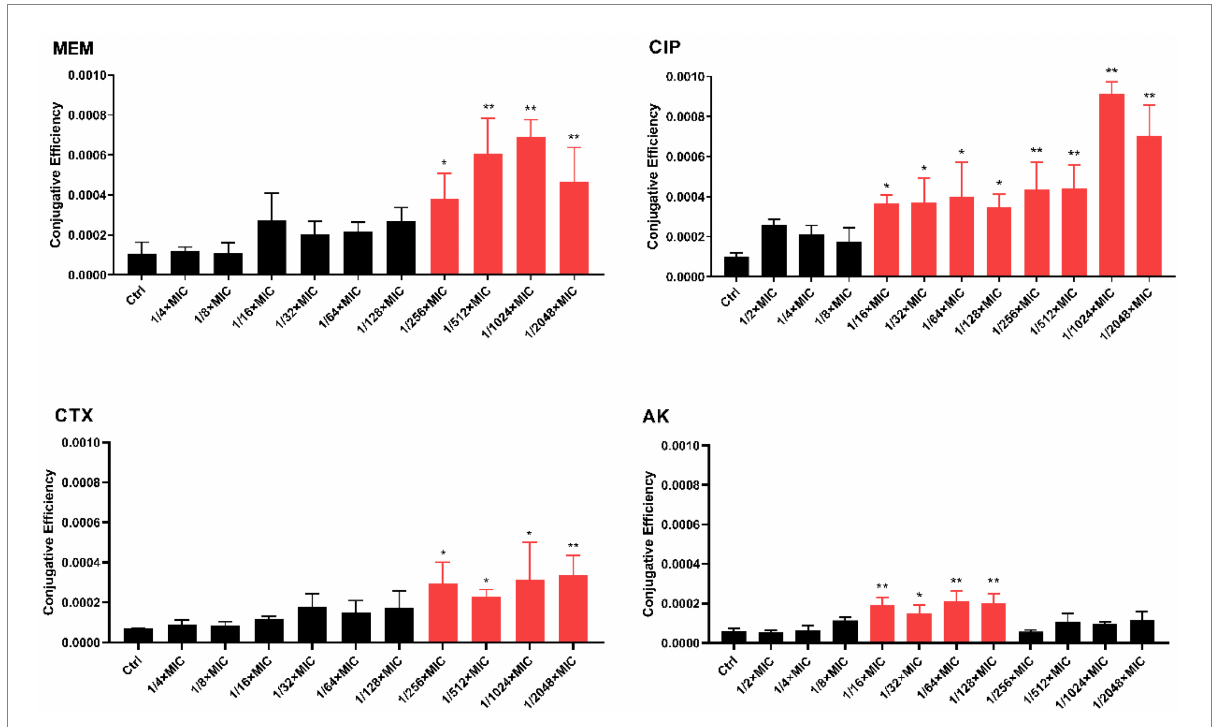
FIGURE 2 In vitro conjugation frequency under expose to antibiotic sub-MICs. The error bar shows the standard deviation. The stars indicate statistical significance at different levels: * P < 0.05, ** P < 0.01.